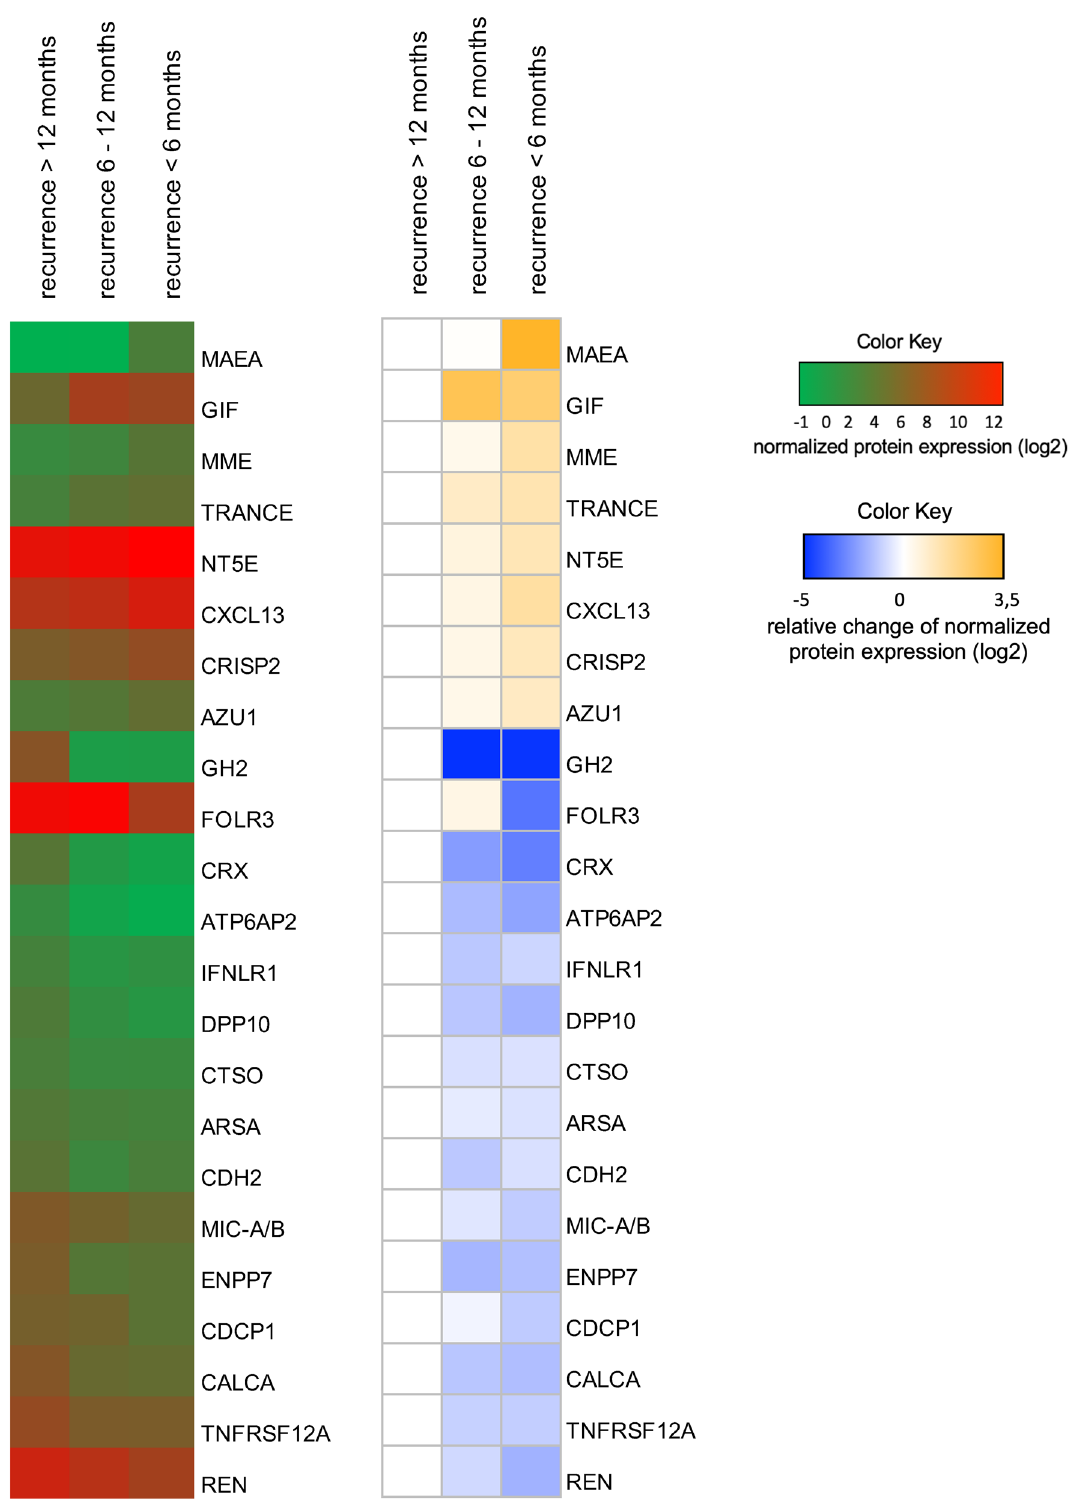
Figure 1. Normalized protein expression of plasma samples from PDAC patients with early (< 6 months), medium (6–12 months) and late (> 12 months) recurrence times. Pooled samples of 4–5 patients per recurrence time were analyzed. The samples were taken one day prior (preoperative sample) and directly after the surgical removal of the specimen. The values for preoperative and intraoperative sample were summarized for the respective recurrence times, since only GH2 showed an influence of the operation on the protein level. The 23 proteins displayed showed at least a twofold change in protein expression between early and late recurrence. Left: Heat map of absolute values, displayed as log2. Right: Heat map of relative values as fold-change in comparison to late recurrence, set to 1, also displayed as